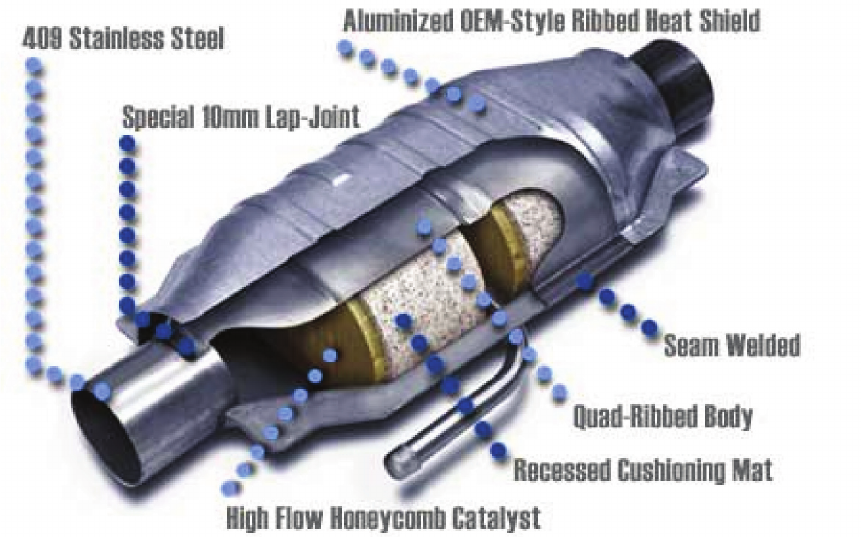
Figure 2: Dissected schematic of the components of a catalytic converter (source: Anonymous 1, 2009: Online)